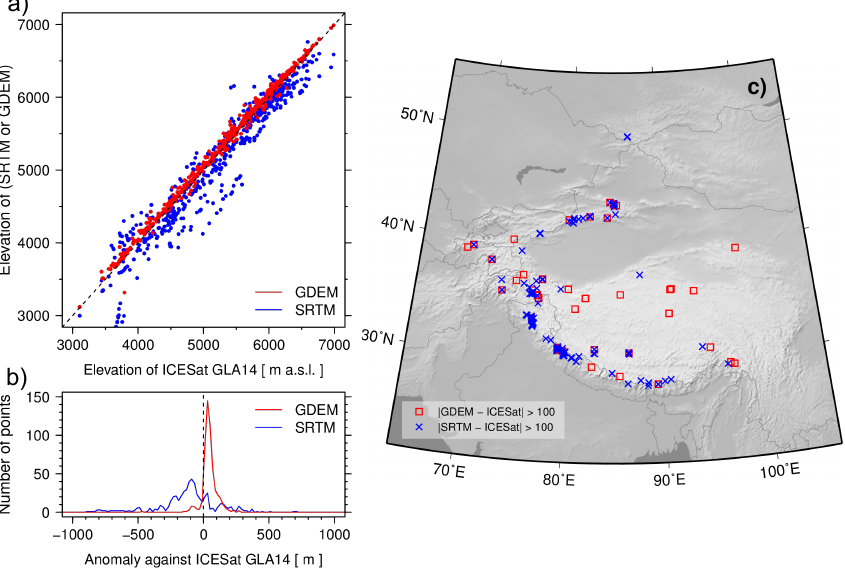
Figure 3. Evaluation of DEMs based on ICESat GLA14. Where large ( > 100m) differences exist between SRTM and ASTER GDEM (version 2) data sets, we compared modelled elevations to those of ICESat GLA14: (a) scattergram, (b) histogram, and (c) spatial